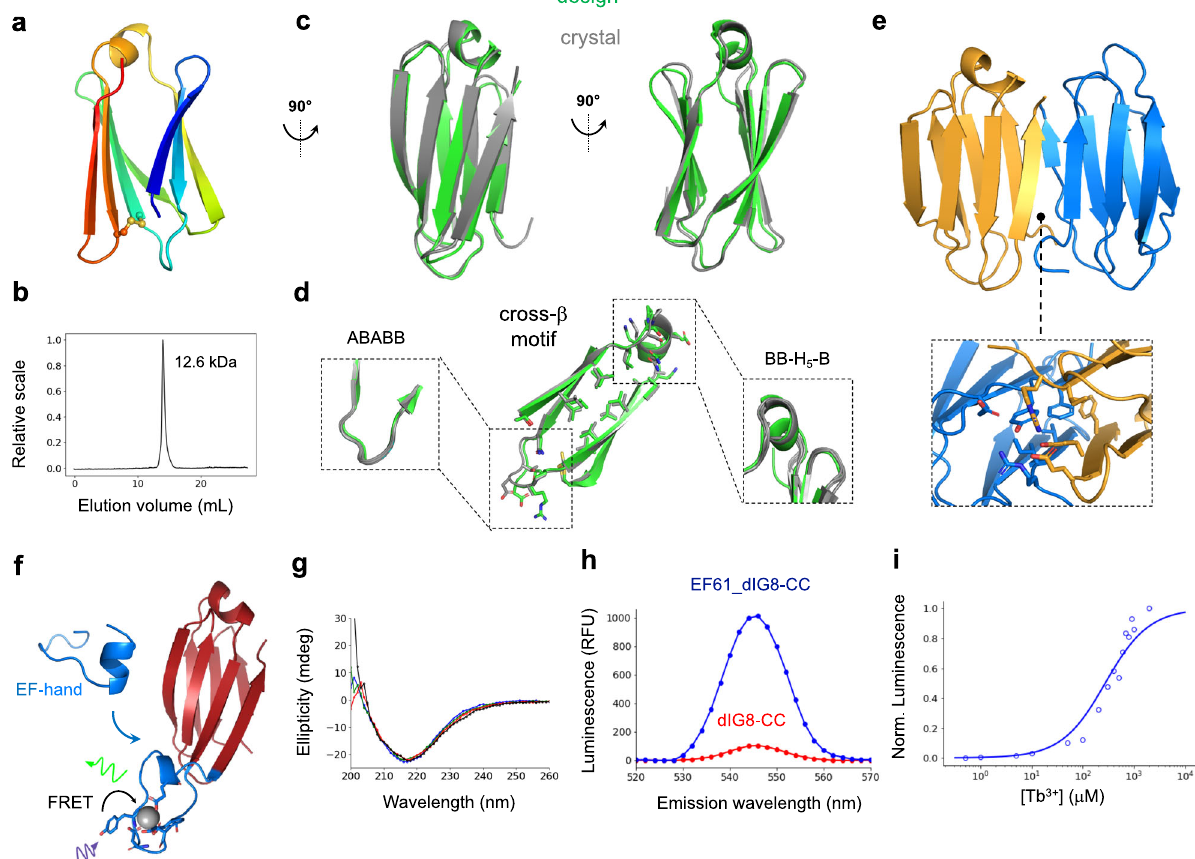
Fig. 5 | Crystal structure of dIG8-CC and functional loop scaffolding. a Design model of dIG8-CC with a disul fi de bridge (spheres) between β -strands 3 and 6. b SEC-MALS analysis of dIG8-CC estimates a molecular weight between monomer (8.3kDa) and dimer (16.6kDa). c Design model (green) in comparison with the crystal structure with PDB accession code 7SKP (gray, chain C). d Cross- β motif connectionsandcoresidechaininteractionsinthedesignandthecrystalstructure. The β -arch helix and loop conformations are well preserved across monomer copies in the crystal asymmetric units (insets). e Crystal homodimer interface by parallel pairing between the two terminal β -strands, which are stabilized through hydrophobic and salt-bridge interactions (inset). f Computational model of dIG8- CC with a grafted EF-hand motif (design EF61_dIG8-CC, cartoon), showing Tb 3+ (sphere) bound to EF-hand motif residues (sticks). Tb 3+ luminescence is sensitized